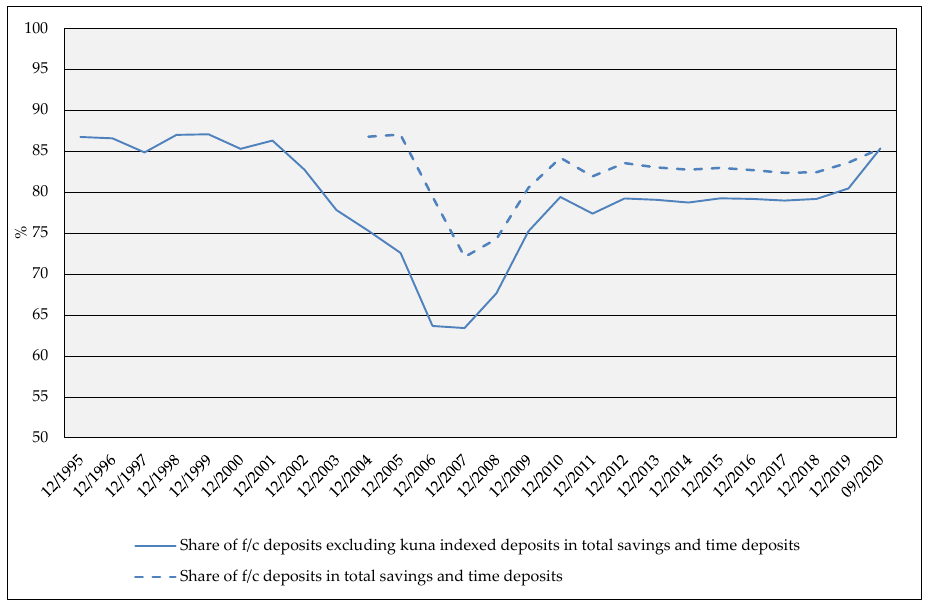
Figure 3. Foreign currency deposits in the Croatian banking sector (in %), December 1995–September 2020. Source: Author’s presentation of the CNB data, official website, based on excel table e-mp_15–Euroization. 2 (CHF mismatch index = (CHF liabilities–(CHF assets–CHF loans to resident households and nonfinancial corporations))/Total assets × 100 (Ye¸sin Table 4. Pearson’s correlation between 6-month LIBOR major currencies, 2 January 2002–2 Decem- 2013, p. ber 2020 ( N = 4784).